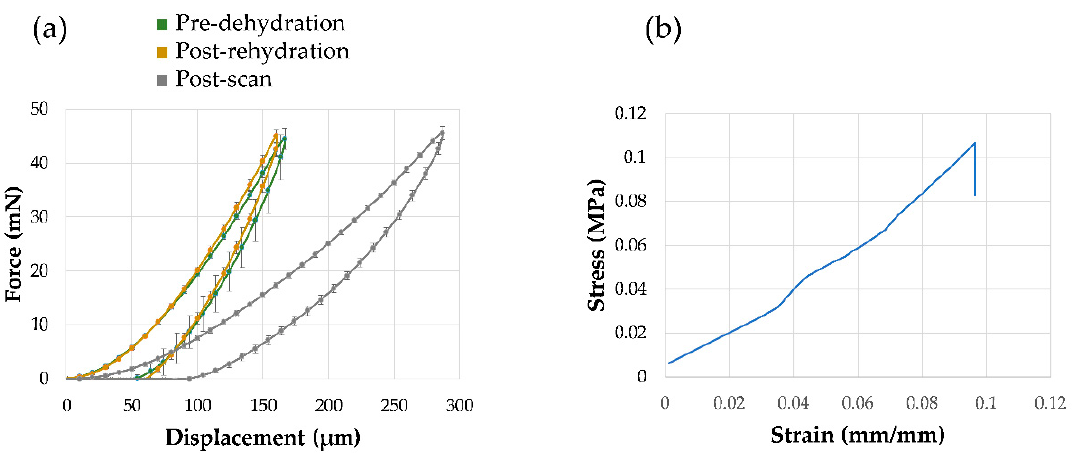
Figure 7. Mechanics of CB5. ( a ) Average force-displacement indentation curves of the cartilage articular surface for fresh tissue, after de / re-hydration and after two consecutive XCT acquisitions at 4 × propagation distance. ( b ) Stress-strain response of the cartilage-bone plug after one cycle of unconfined compression applied to the cartilage articular surface (~10% of the articular cartilage thickness).